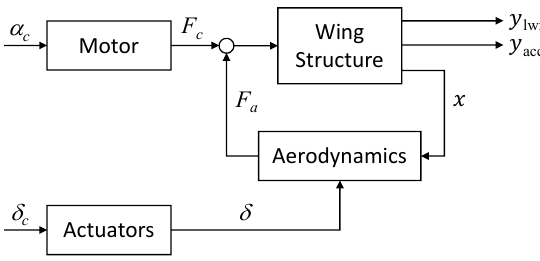
Figure 4. Schematic block diagram of the elastic wing model structure including aerodynamics, elastic structure, control surface actuators and pitch